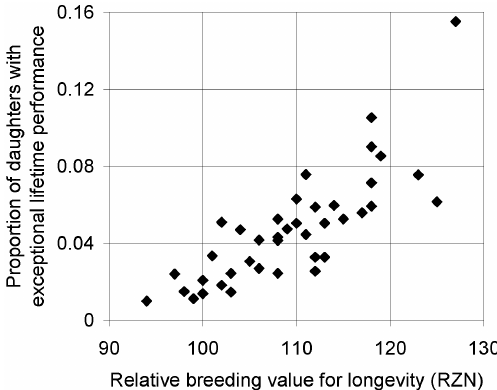
Figure 3. Proportion of exceptional cows compared with the rel- ative breeding values for functional longevity (RZN) for sires ( n = 48) with more than five daughters with exceptional lifetime